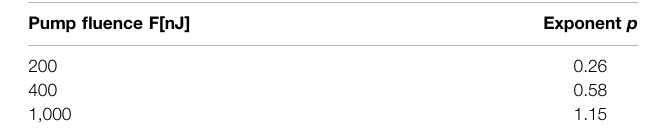
TABLE 2 | Dependence of the exponent p in the expression D T 1d ( t ) ∼ t − p for the diffusion coef fi cient of triplets on the pump fl uence F